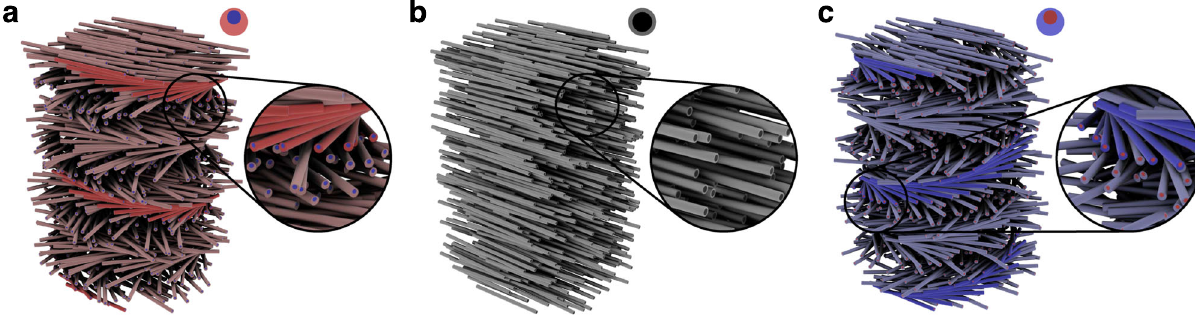
Fig. 6 Idealised structures of the left, nematic and right structures formed by self-assembled cellulosic chains (rods). a Left-handed helicoidal structures formed by rods (cross-section shown in the upper right corner) that expose hydrophobic groups of cellulose (red colour) and hide the hydrophilic groups (blue colour) asymmetrically from the interface, along the rods, due to the chirality of the cellulose main chain. b Nematic structure formed by symmetric rods (cross-section in the upper right corner). c Right-handed helicoidal structures formed by rods (cross-section shown in the upper right corner) that expose cellulose hydrophilic groups (blue colour) and hide the hydrophobic groups (red colour) asymmetrically along the rods. In this work, we give evidence of the formation and motion of travelling structural coloured patterns in cellulose-based liquid crystalline materials, produced by a reaction/diffusion mechanism and the evaporation at boundaries. The beauty of the system consists not only in its travelling colourful patterns, driven by self-adjustment of the conformation of the cellulosic chain to the environment, but also in the preservation of the chirality of the precursor solutions characteristics, at a given instant, into solid fi lms. Our results also indicate that inversion of the helix hand- edness, at the micro/nanoscale systems, should come from small self-conformational changes of the cellulosic chains. The oscil- lating inversion of the helix handedness and the formation of spatiotemporal structures opens a new fi eld of applications, with no need of the use of sophisticated techniques; the same initial formulation is at the origin of solid matrices with distinct chiral photonic characteristics. Foreseen technological applications include the manipulation of structural colours, the preparation of templates and the design of hydrophilic/hydrophobic surfaces on demand. re fl ection of light. When this is veri fi ed, the microscope slide is immersed in liquid